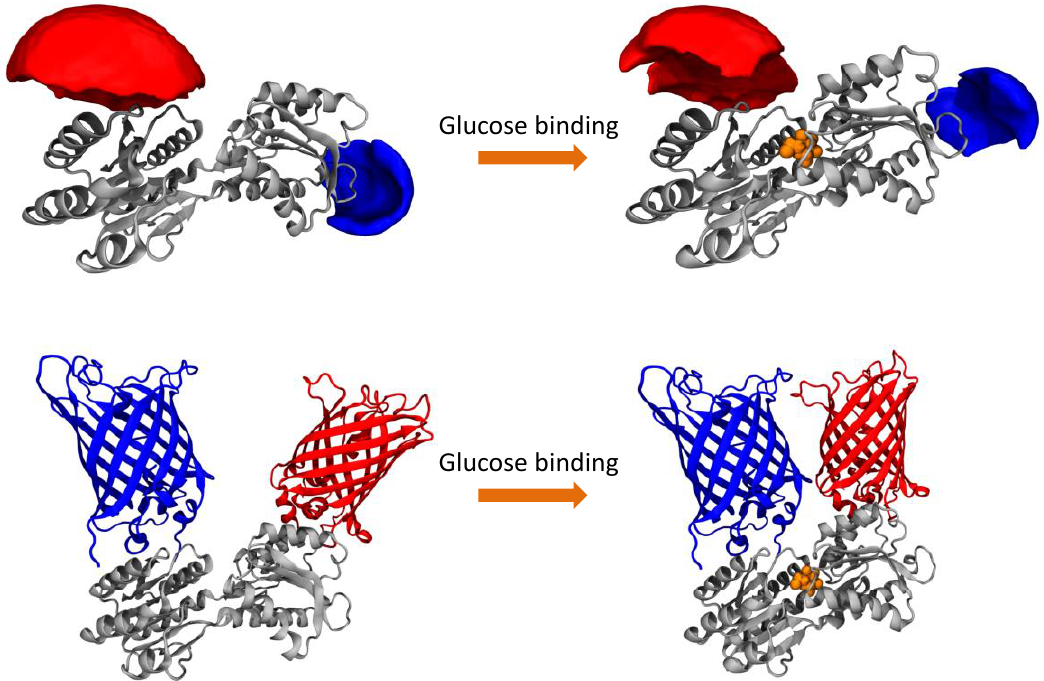
Figure 1. (upper panels) Illustration of chosen dye labeling positions to design a FRET-based glucose sensor: 3D structures of ligand-free (left structure; 2FW0) and ligand-bound MglB (right structure; 2FVY) shown together with calculated AVs for donor (blue volumes, attached at position 137) and acceptor (red volumes, attached at position 42) dyes. Note the conformational change of the MglB structure induced by glucose (orange spheres) binding. (lower panels) For comparison, an equivalent illustration of both MglB structures is shown with donor FPs (blue, inserted at position 12) and acceptor FPs (red, inserted at the C-terminus). The relative orientations of the FPs are arbitrary and not based on experimental measures.